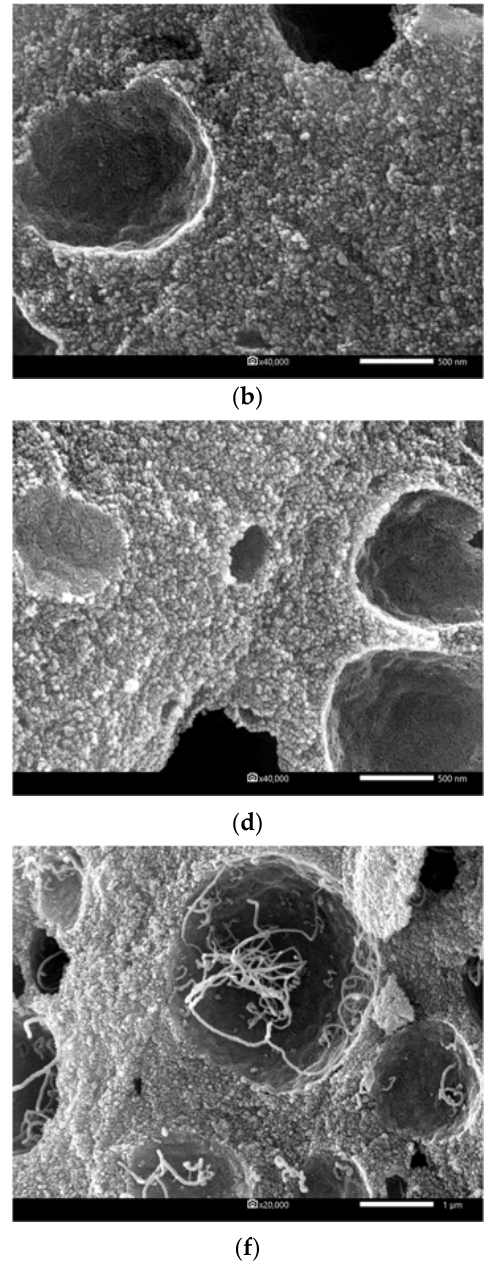
Figure 1. SEM images of the 5CoC x /Al 2 O 3 catalysts prepared at different temperatures, ( a ) 300 °C, ( b ) 400 °C, ( c ) 500 °C, ( d ) 600 °C, ( e ) 700 °C, ( f ) 800